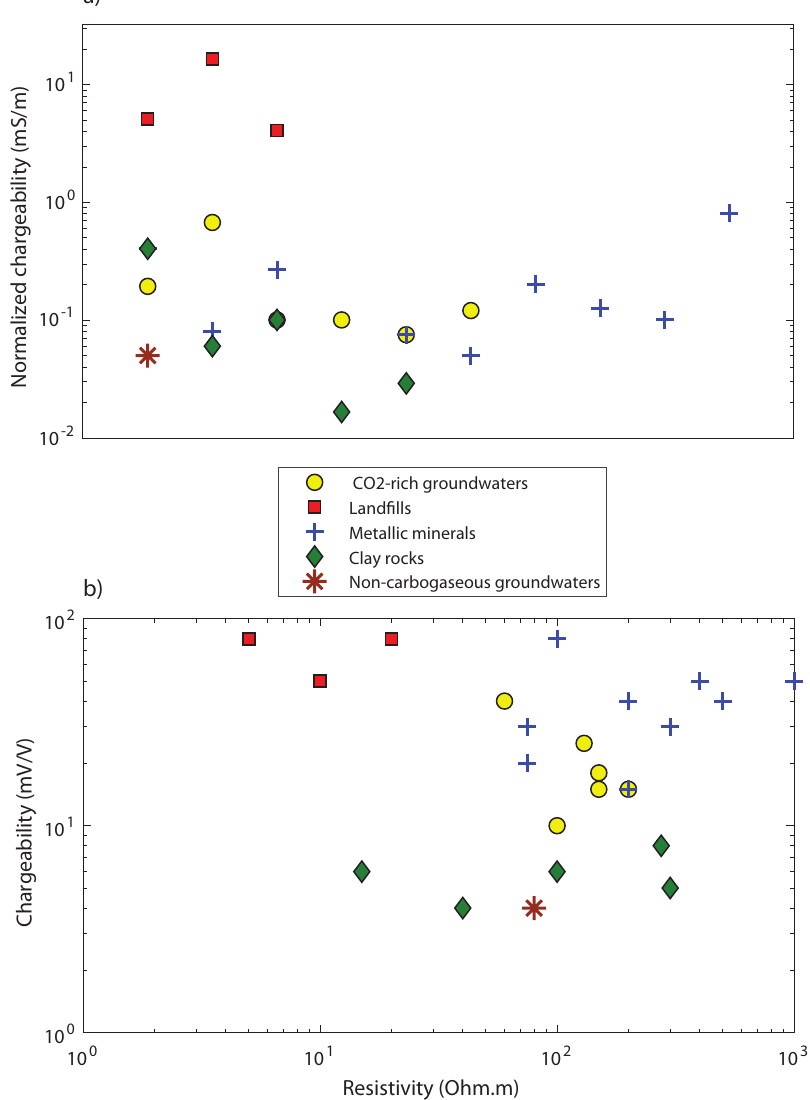
Figure 12. ( a ) Logarithmic representation of the normalized chargeability values produced by different geological contexts. ( b ) Representation of these anomalies in the chargeability vs. resistivity